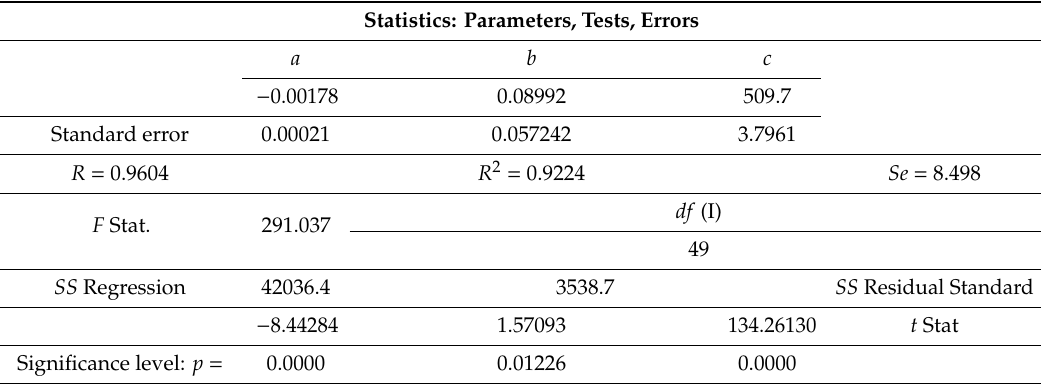
Table 2. The statistical significance for the model: y = − 0.0018 x 2 + 0.0899 x + 509.66.